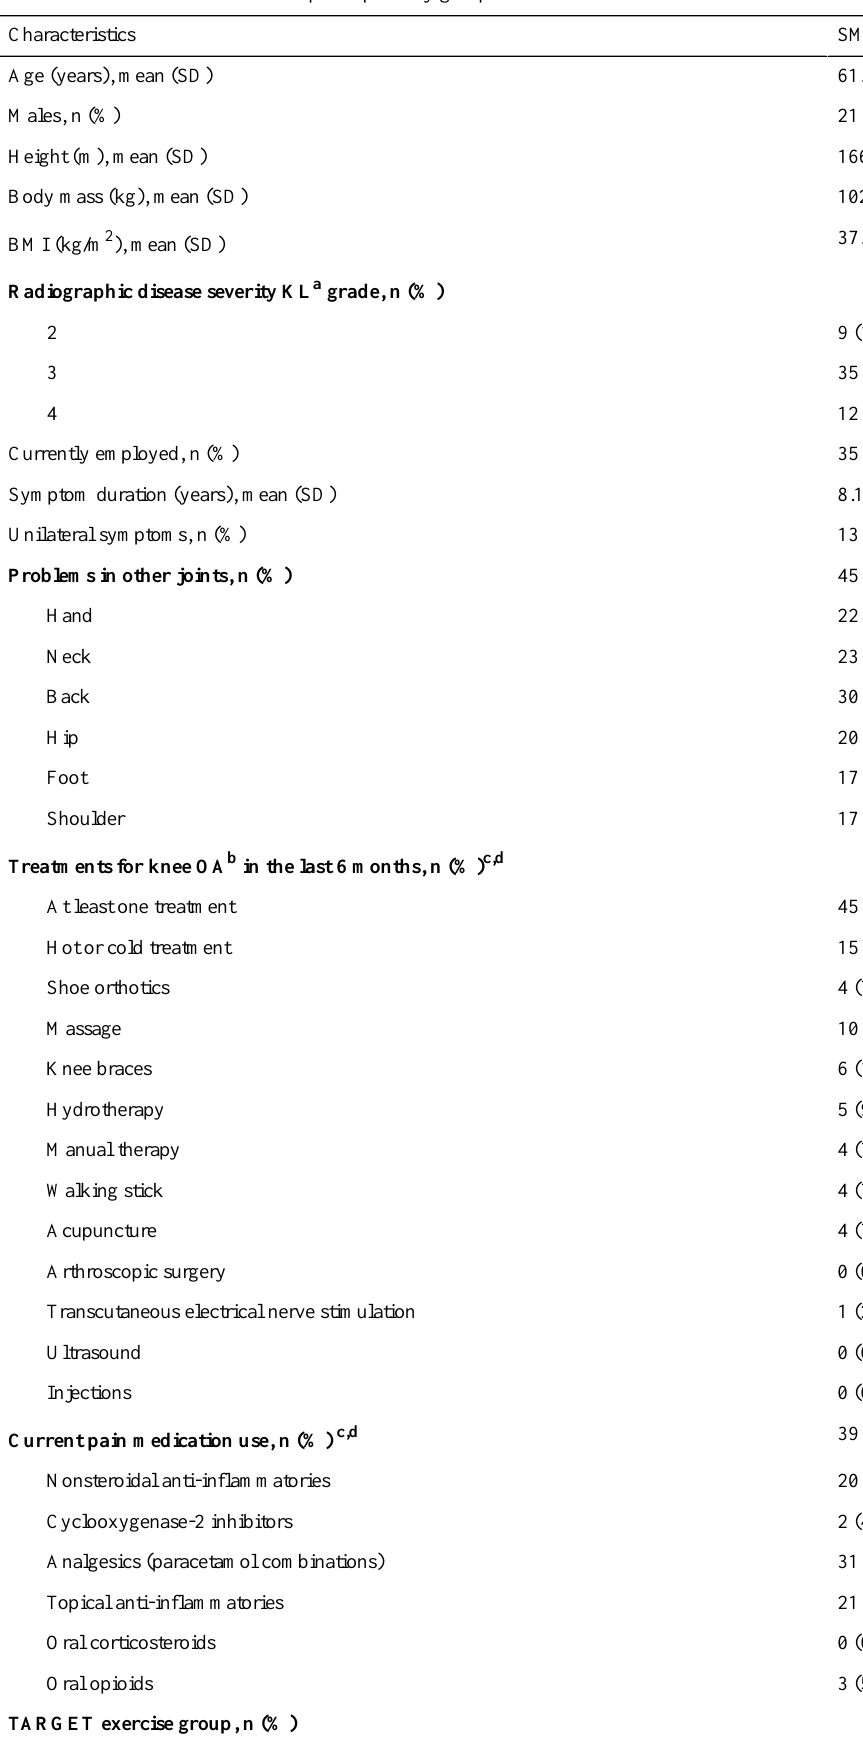
Table 1. Baseline characteristics of participants by